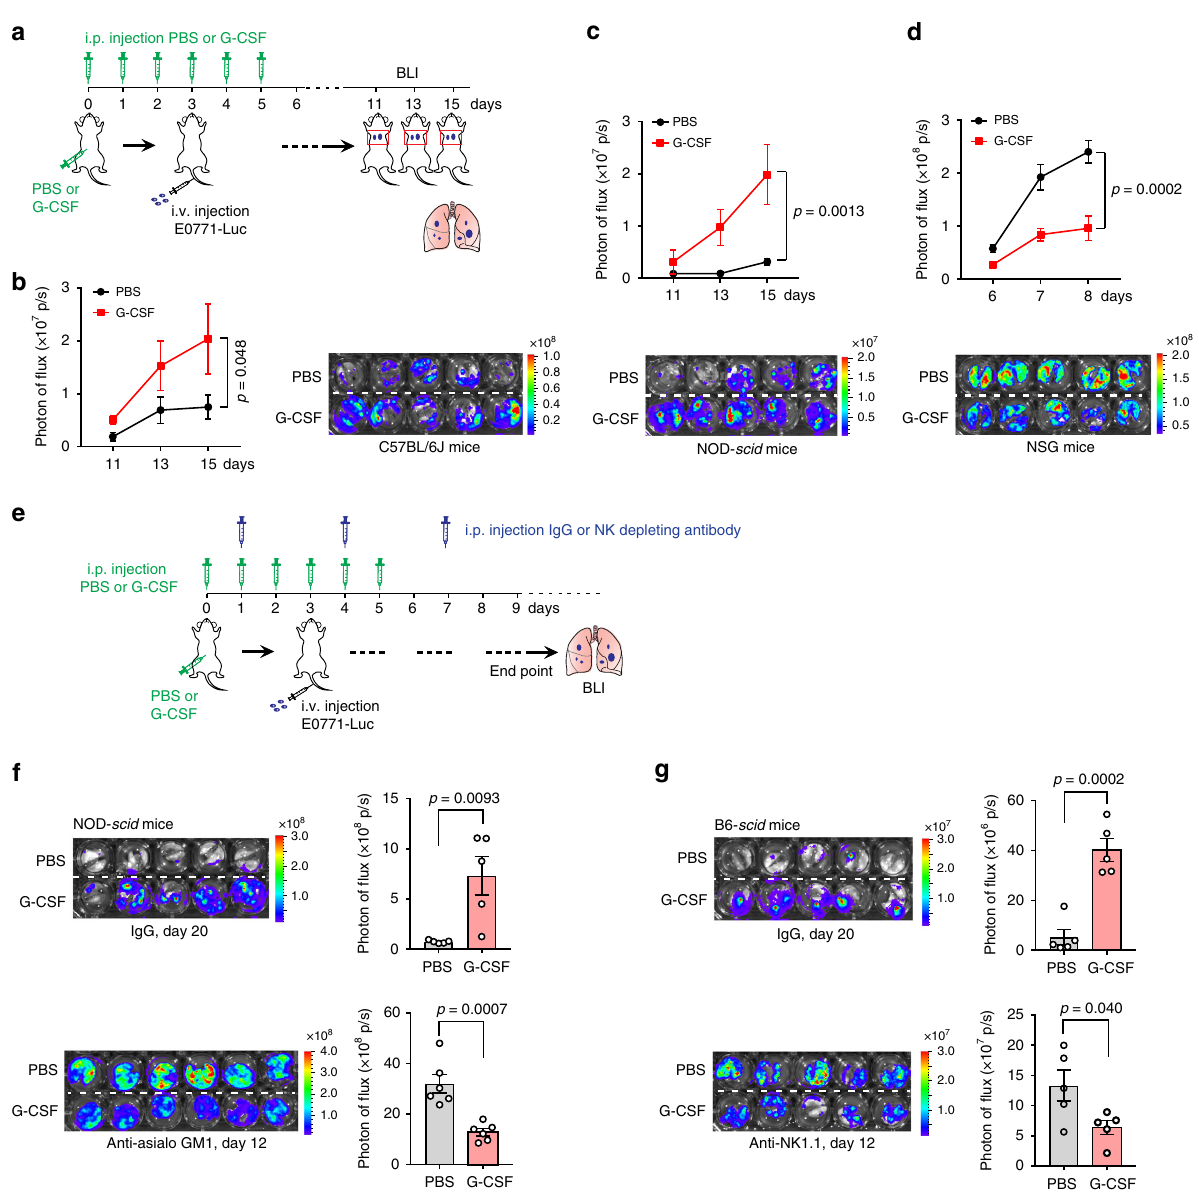
Fig. 1 G-CSF-induced neutrophilia exerted pro-metastatic and anti-metastatic effects in NK cell-competent and NK cell-de fi cient mice, respectively. a – d G-CSF administration showed distinct effects on breast tumor cell colonization in the lungs of C57BL/6J ( b ), NOD- scid ( c ), and NSG mice ( d ). As depicted in a , all mice received intraperitoneal (i.p.) injection of recombinant mouse G-CSF (2.5 μ g per mouse) for 6 consecutive days. On day 3, the mice were implanted with E0771-Luc cells by intravenous (i.v.) injection. The metastatic progression of E0771-Luc cells was then monitored by bioluminescence imaging (BLI). Quanti fi cation of photon fl ux and comparison of metastatic colonization in the lungs of mice are shown ( b , left; c and d , top), and the endpoint bioluminescence images of lungs are shown ( b , right; c and d , bottom). n = 5 mice per group. P values were determined by two-way ANOVA (PBS group versus G-CSF group). e – g NK cell depletion converted G-CSF-induced pro-metastatic effect to anti-metastatic. As depicted in e , all mice fi rst received i.p. injection of recombinant mouse G-CSF (2.5 μ g per mouse) for 6 consecutive days. To deplete NK cells, NOD- scid mice ( f ) and B6- scid mice ( g ) were i.p. injected with anti-asialo GM1 (25 μ l per mouse) and anti-NK1.1 (25 μ g per mouse), respectively, every 3 days starting from day 1. On day 3, the mice were implanted with E0771-Luc cells by i.v. injection. At the endpoint, the metastatic progression of E0771-Luc cells in the lungs was detected by ex vivo BLI. The endpoint bioluminescence images (left) and the quanti fi cation of photon fl ux of lungs (right) are shown. n = 5 (IgG) or 6 (anti-asialo GM1) NOD- scid mice per group ( f ). n = 5 B6- scid mice per group ( g ). P values were determined by unpaired two-tailed t -test. Data are represented as mean ± SEM. Source data are provided as a Source data fi